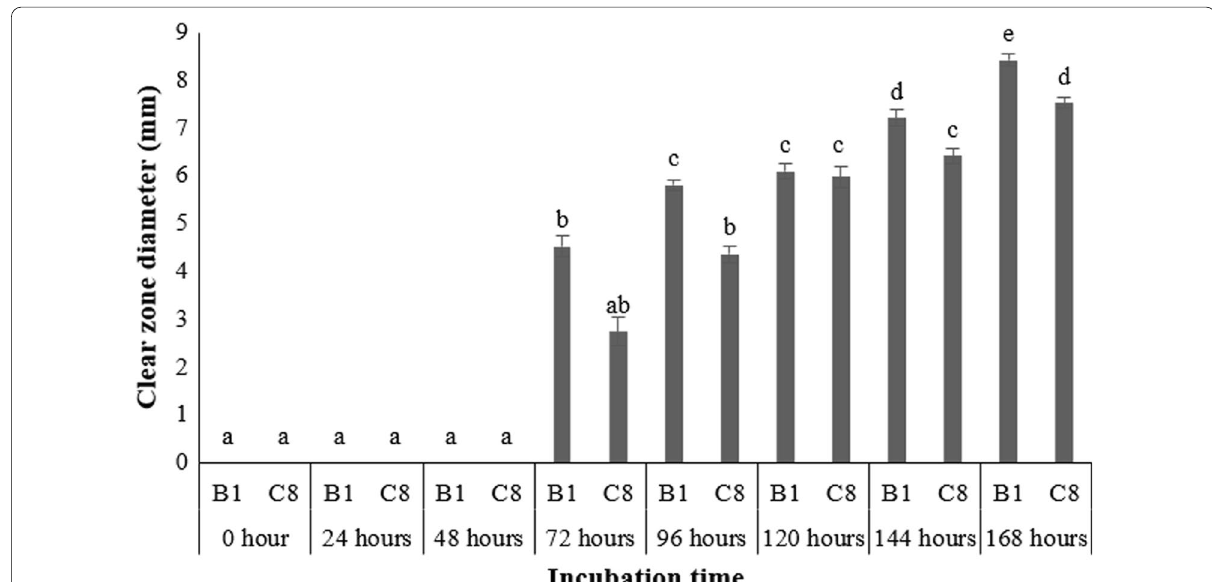
Fig. 2 Inhibitory activities of B1 and C8 bacterial isolates at different culture ages against XCC. Different letters on each histogram indicated any difference in clear zone diameter among bacteria isolates and culture age ( p < 0.05)